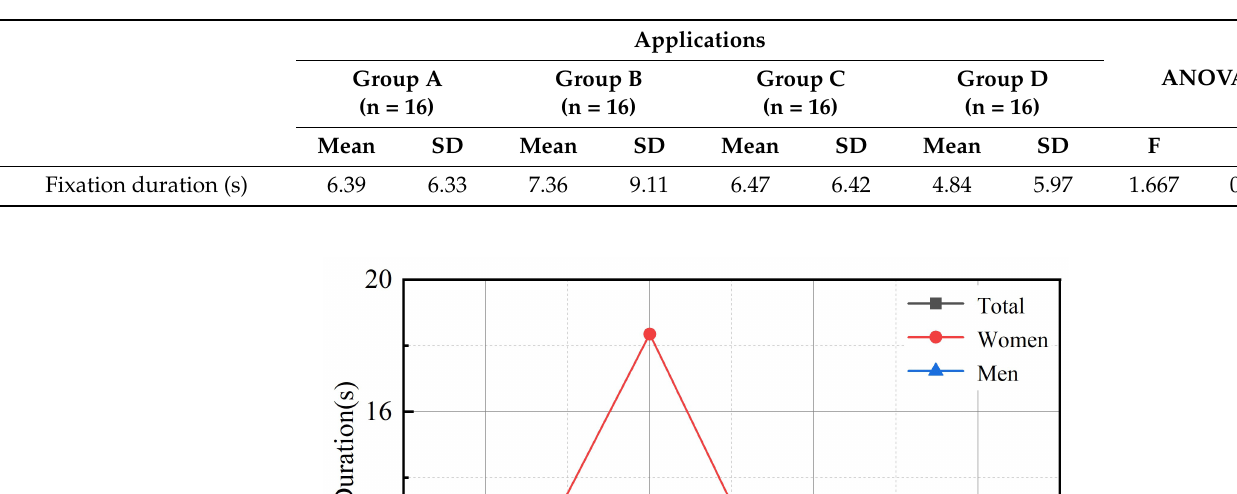
Table 3. ANOVA of participants’ average fixation duration for different Apps: A refers to C-life Senior Care APP; B refers to Senior Living APP; C refers to Senior Care Manager APP; D refers to Smart Aging APP.